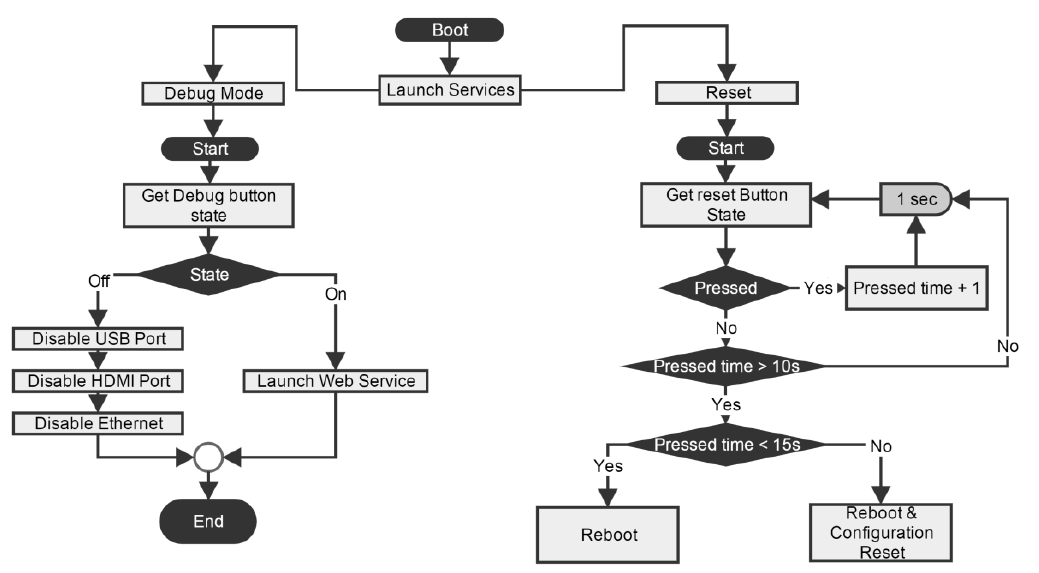
Figure 2. Signal flow diagram of the reset and the power saving buttons monitor services.